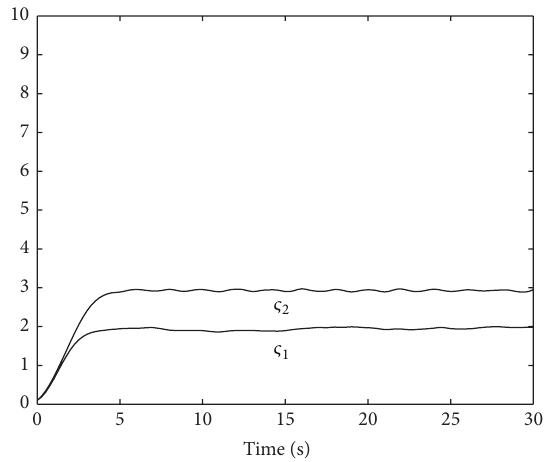
Figure 5: The curve of adaptive parameters 𝜍 1 and 𝜍 2 .